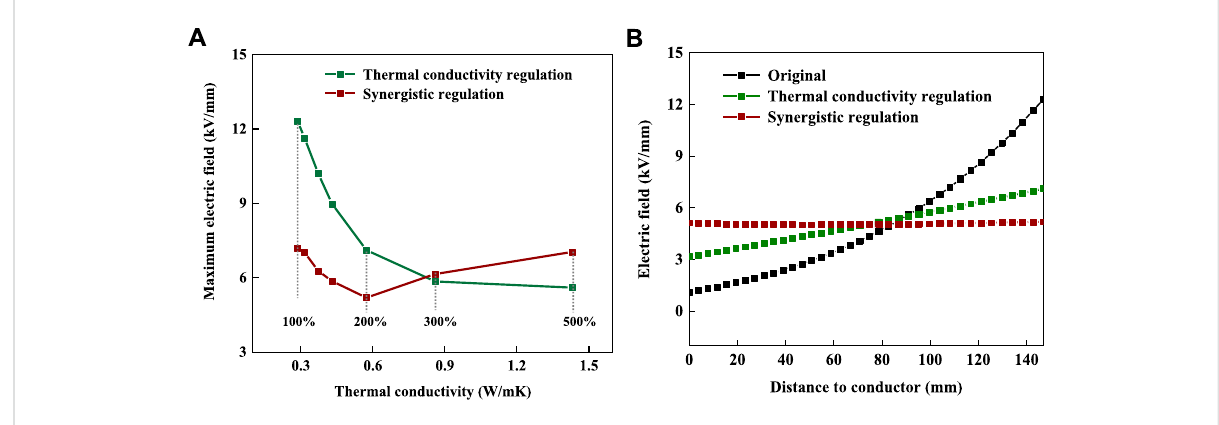
FIGURE 7 In fl uence of synergistic regulation on the maximum electric fi eld within bushing insulation. (A) maximum electric fi eld; (B) electric fi eld